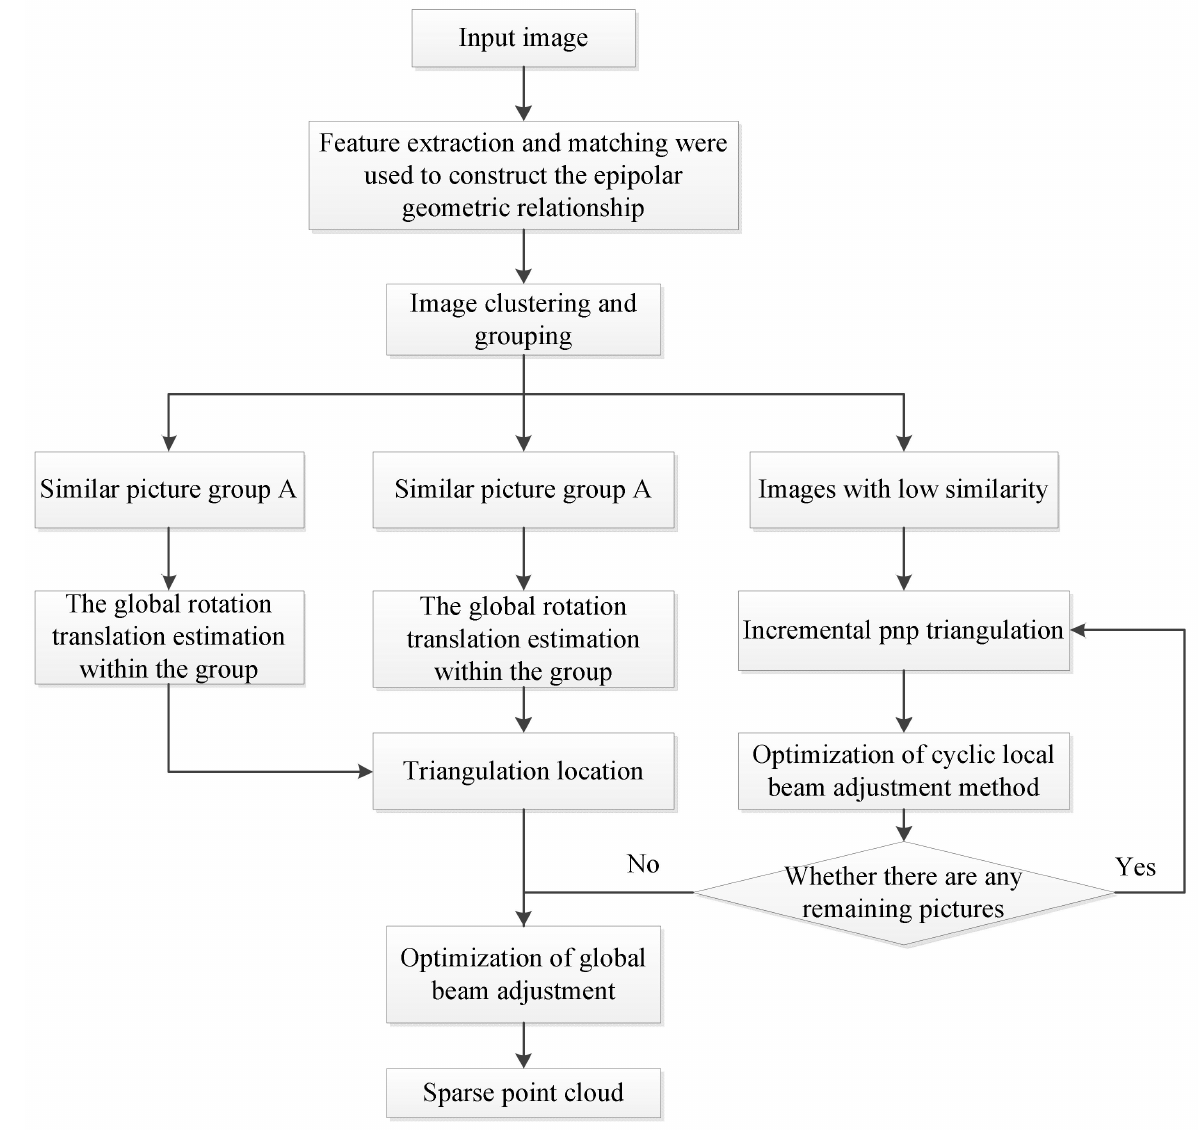
Figure 5. Flow chart of Integrated SFM